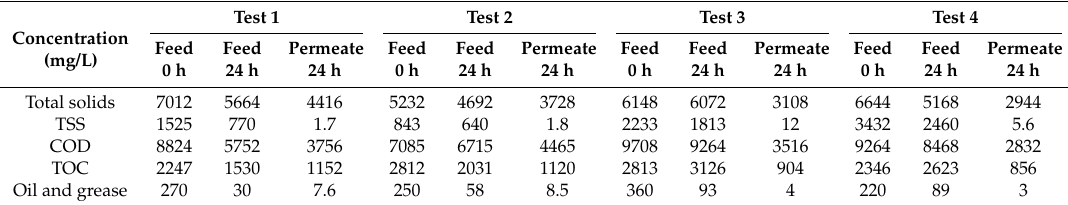
Table 6. Characterization of feed and permeate in terms of total solids, total suspended solids (TSS), chemical oxygen demand (COD), total organic carbon (TOC) and oil and grease in tests 1–4.